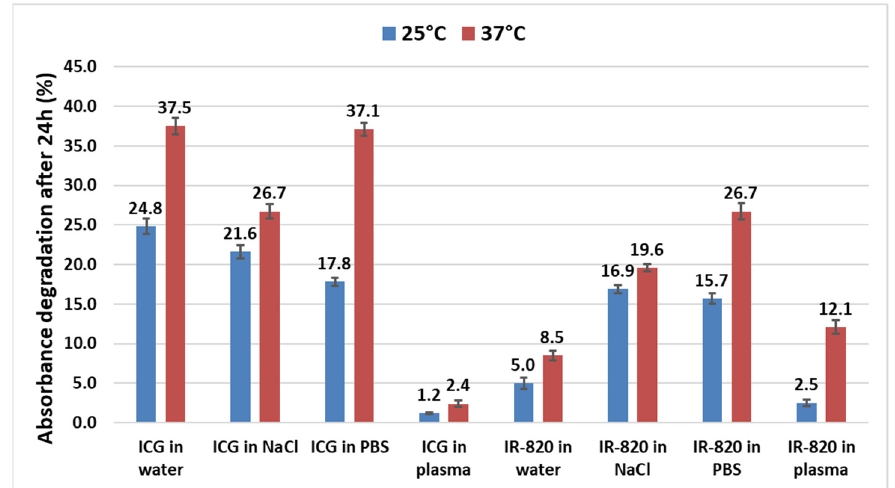
Figure 3. Temperature stability study of ICG and IR-820 solutions in different solvents at 25 and 37 °C. Absorbance decrease (%) after 24 h incubation in the dark was calculated from the absorbance peak values measured before and after incubation. Measurements were performed in triplicate. Statistical analysis confirmed that the means of each data pair (sample at 25 and 37 °C) are not equal, and therefore, the absorbance values differ significantly ( p < 0.05).